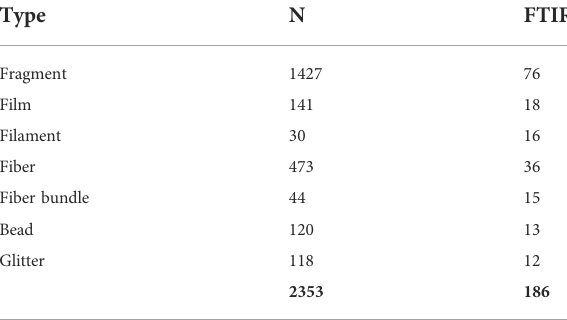
TABLE 2 Number (N) of particles per type and respective amount of items selected for